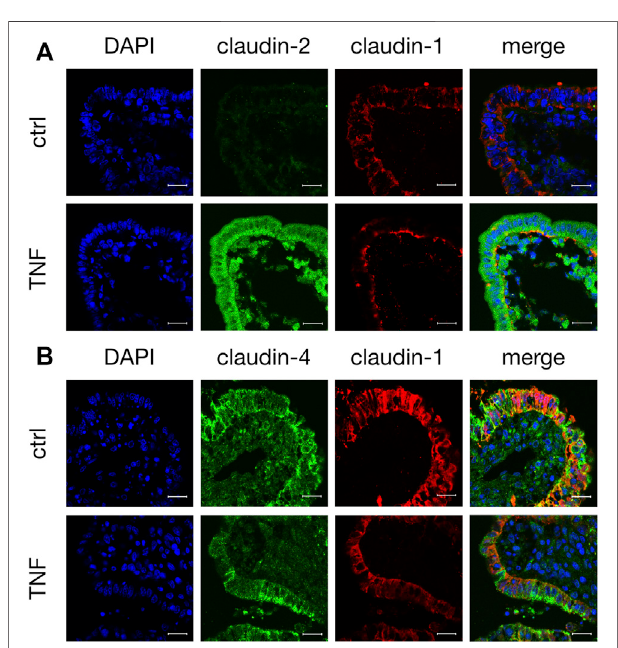
FIGURE 6 | Immunohistological staining of affected TJ proteins after TNF incubation (A) Confocal laser scanning immuno fl uorescence microscopy of claudin-2 (green) and claudin-1 (red) after 10 h incubation of tissue in the Ussing chamber with or without 5000 U/ml TNF (B) Staining of PP FAE for claudin-4 (green) and claudin-1 (red). Cell nuclei werestained blue by DAPI (scale bar: 20 μ m, n = 3, representative images).